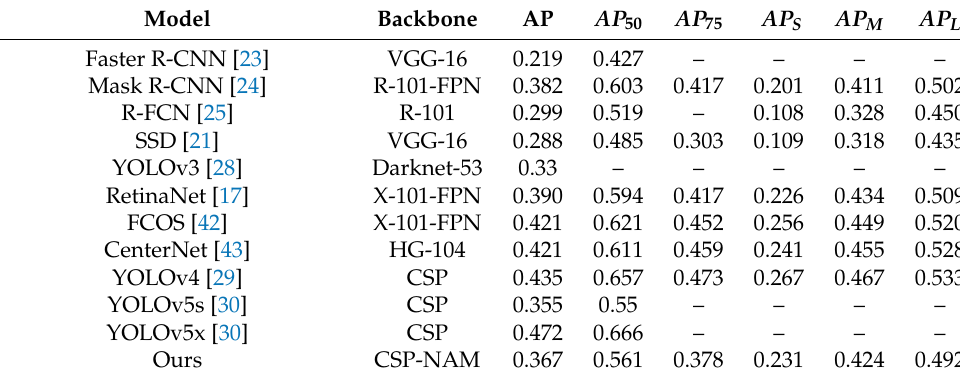
Table 5. Detection results on the COCO